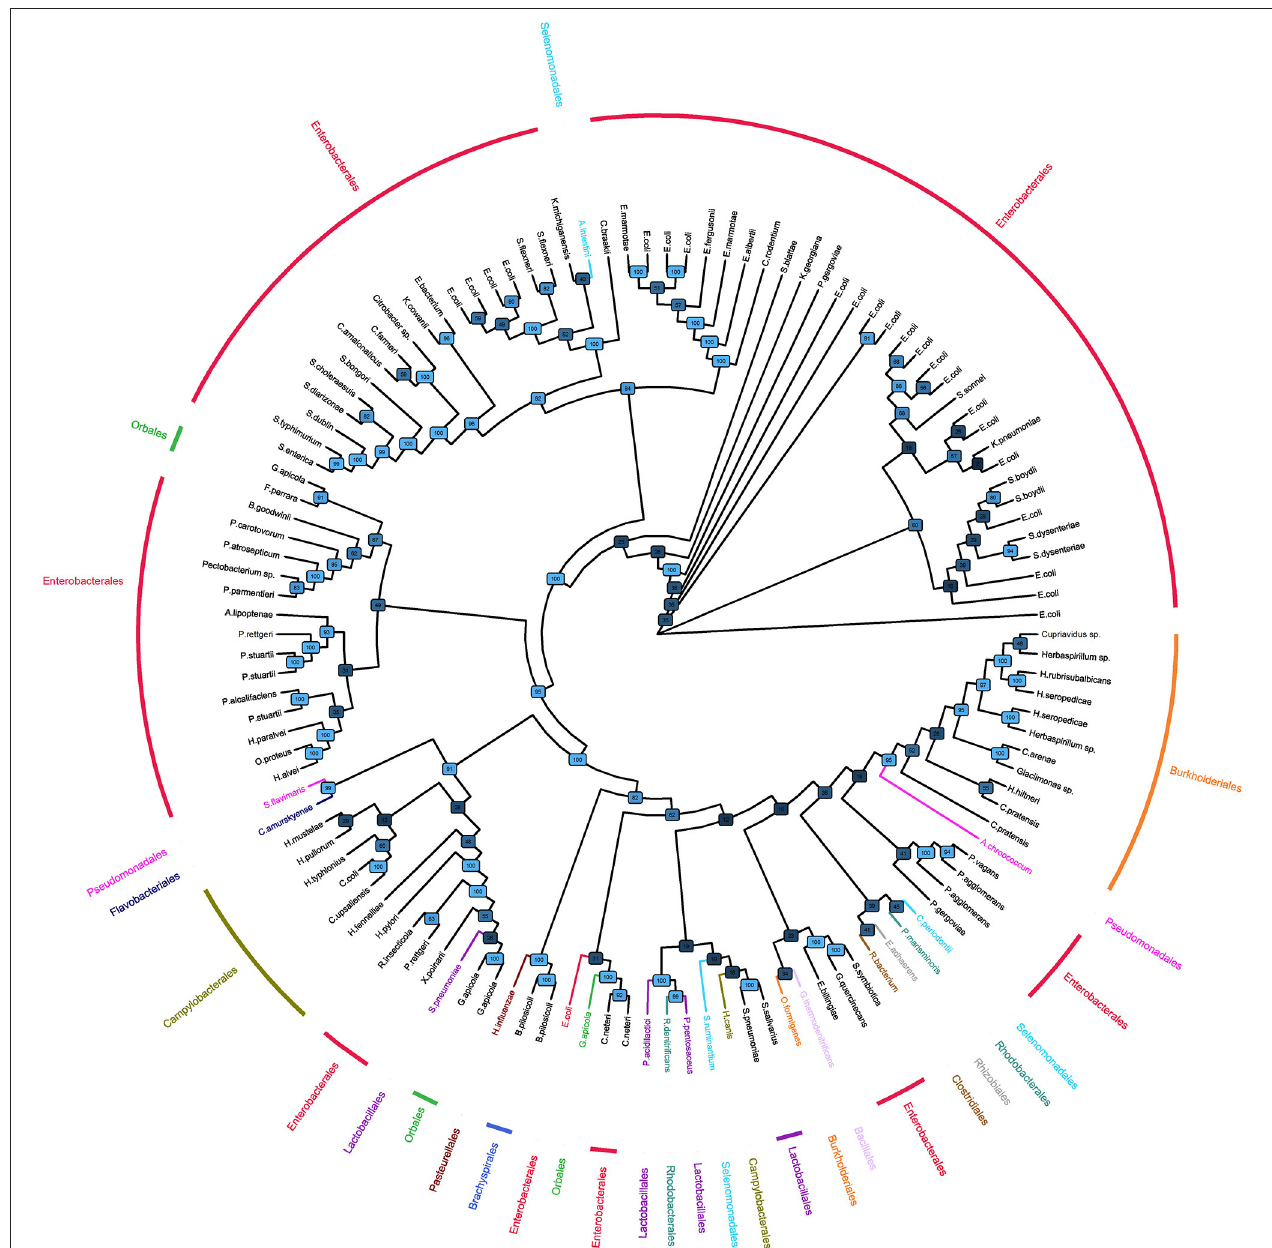
FIGURE 1 | Phylogenic tree of bacteria bearing α 1,3GT sequences. Phylogenetic tree of bacteria based on the α 1,3-GalactosylTransferase sequences retrieved on KEGG and UniProt databases. Orders have been represented in different colors. The tree is represented as a cladogram; therefore, the interpretation of the groups is possible but the branch length has no meaning. Bootstrap confidence values are indicated on